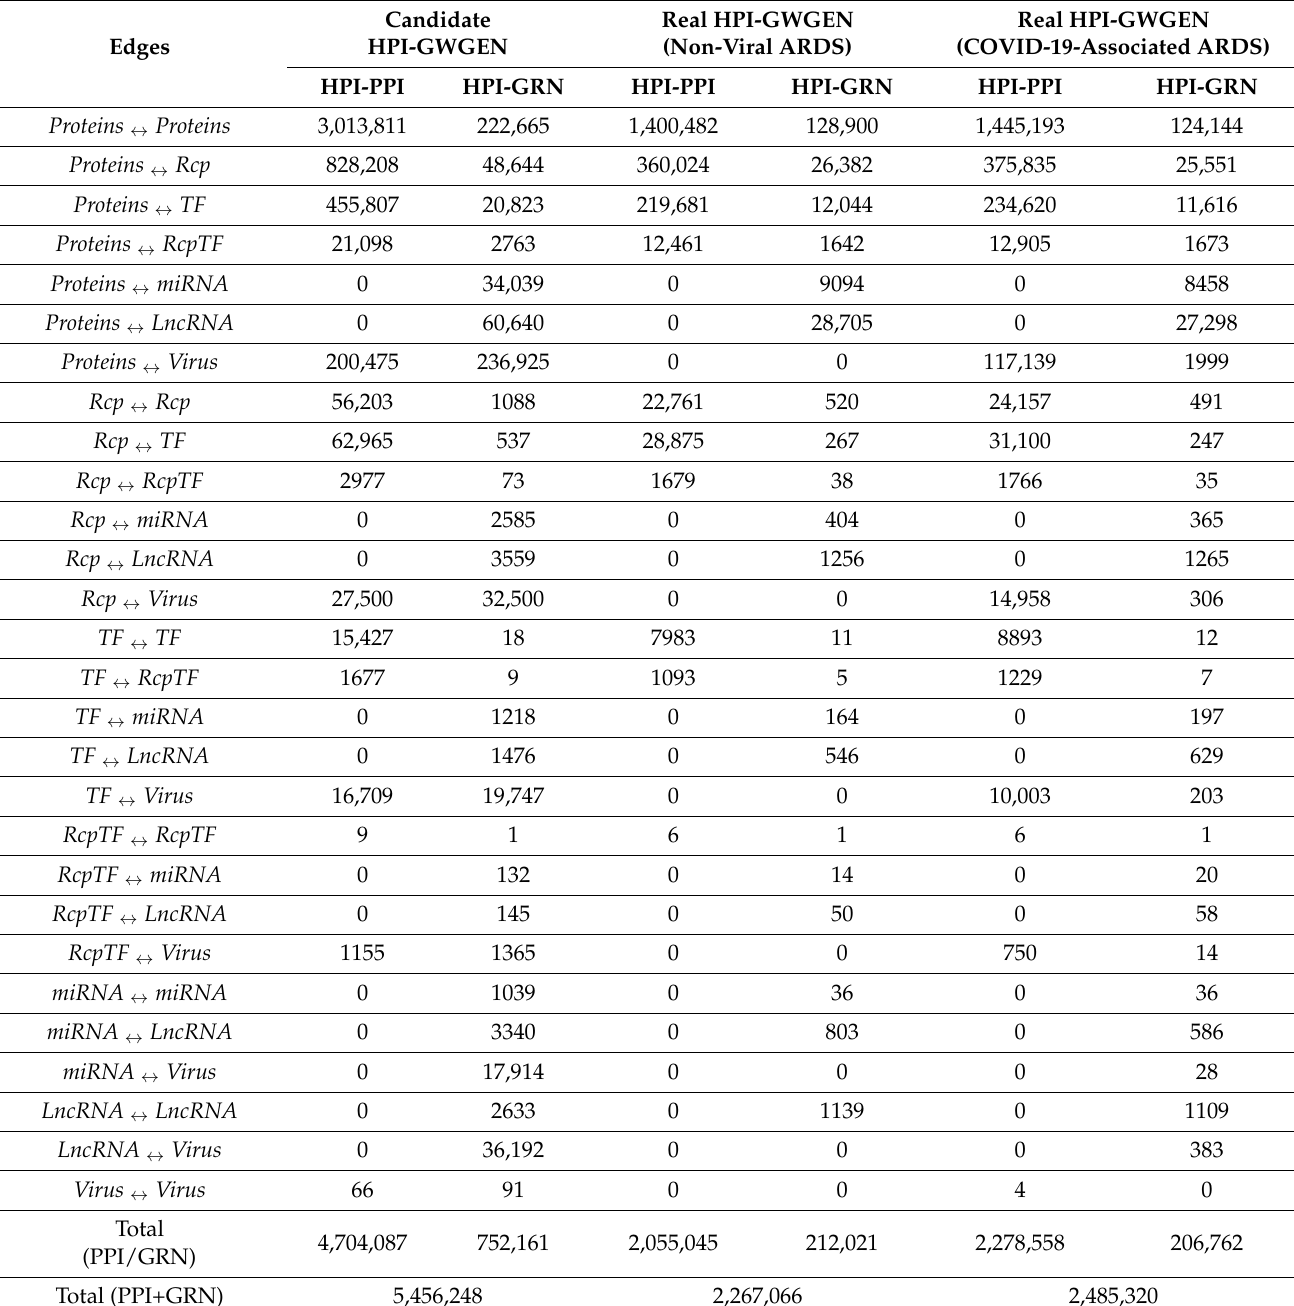
Table 3. Comparison of numbers of edges in candidate HPI-GWGEN, real HPI-GWGEN of COVID- 19-associated ARDS, and real HPI-GWGEN of non-viral ARDS after system